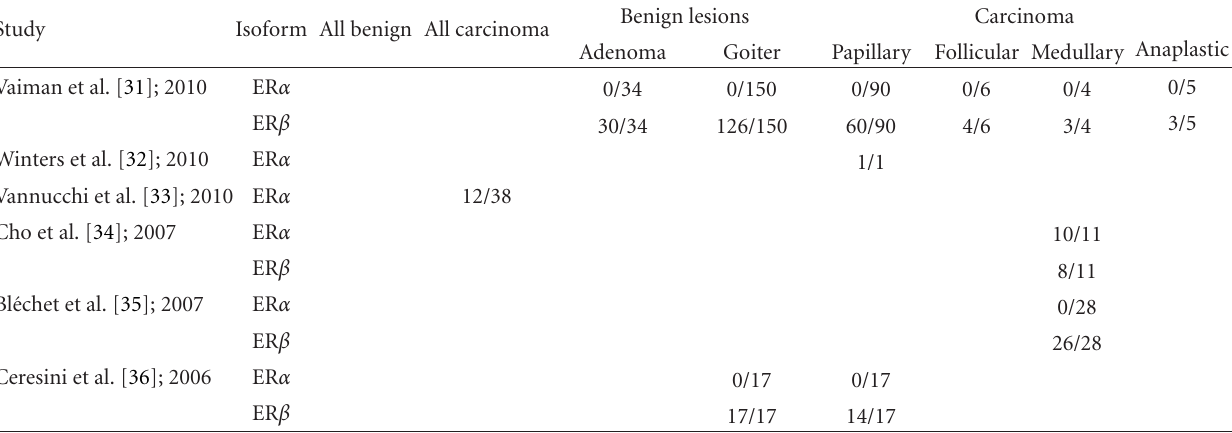
Table 2: Estrogen receptors (ER) α and β in human normal thyroid, and benign and malignant thyroid diseases, by immunohistochemistry